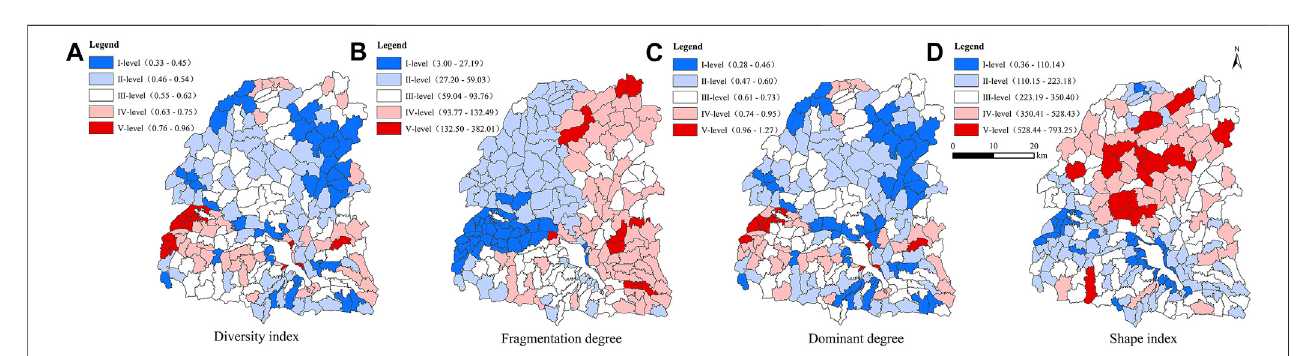
FIGURE 4 | landscape index distribution map of REL.